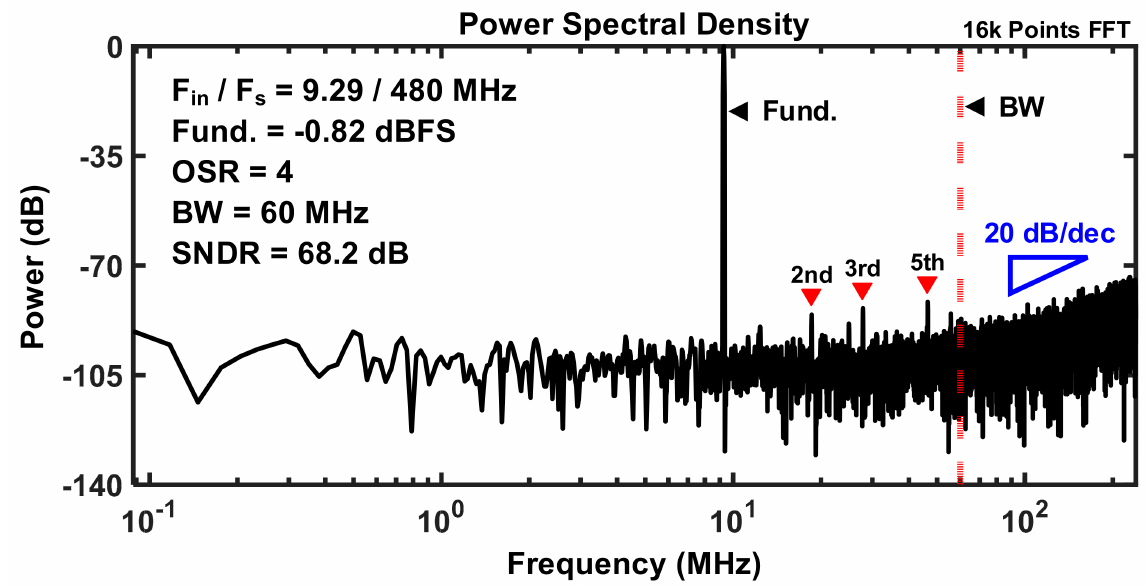
Figure 12. Simulated output power spectral density of proposed